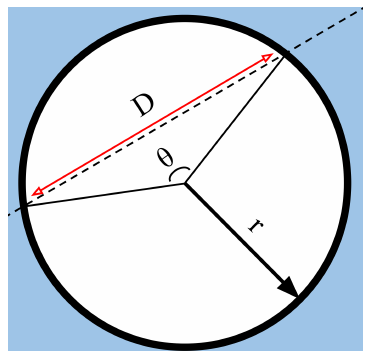
Figure 1. Relating a floe chord to floe size for a circular floe. A satellite track (dashed black line) passes over a floe of radius r (solid black line). The track records a series of echoes of length D , which is the length of a chord (red line) identified by its interior angle, θ